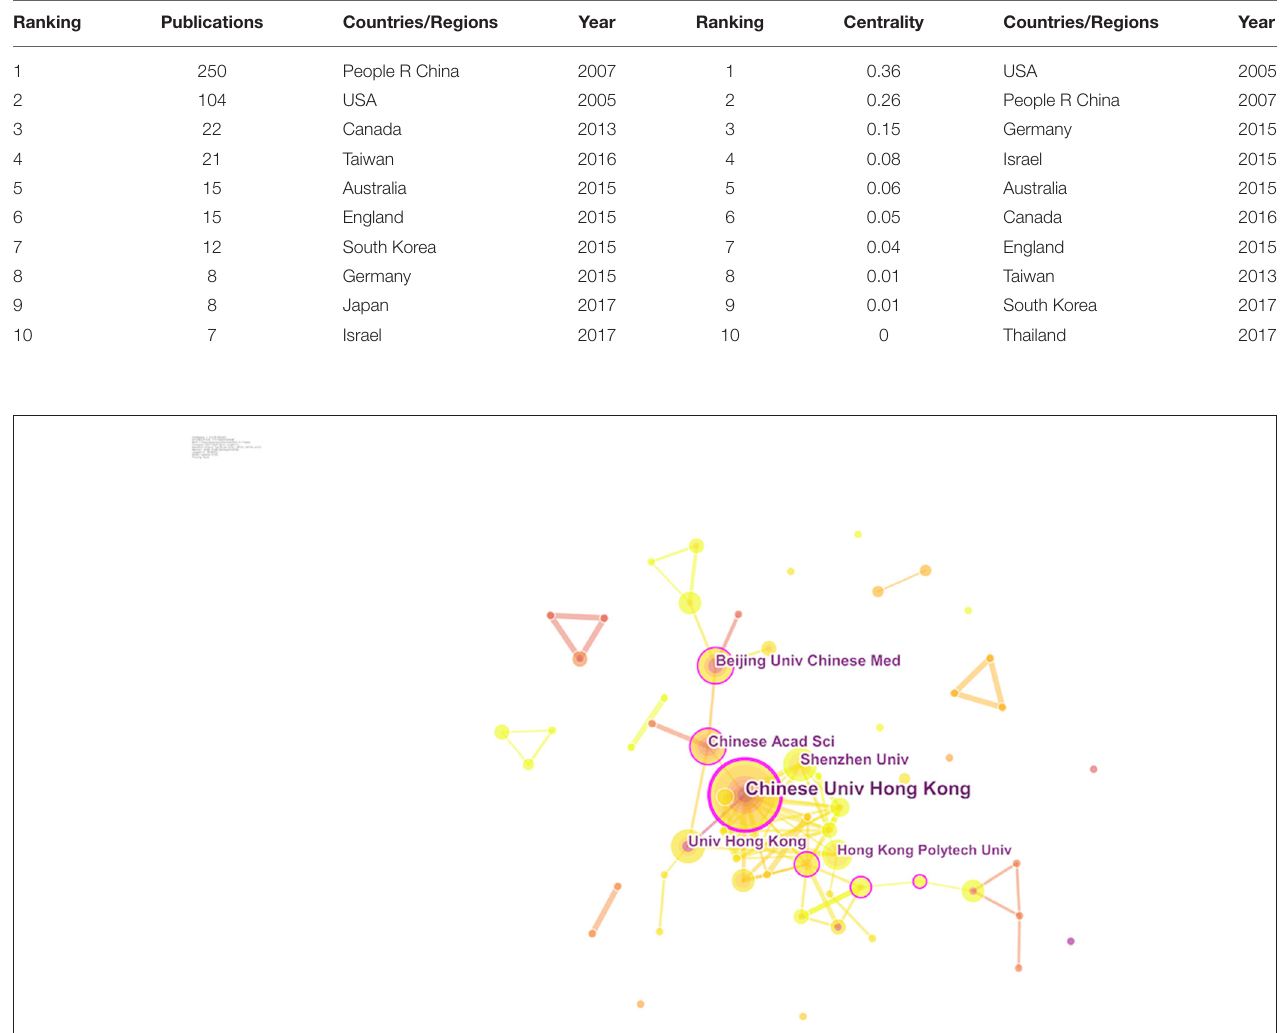
TABLE 2 | Top 10 countries/regions in terms of publications and centrality from 2001 to 2020.